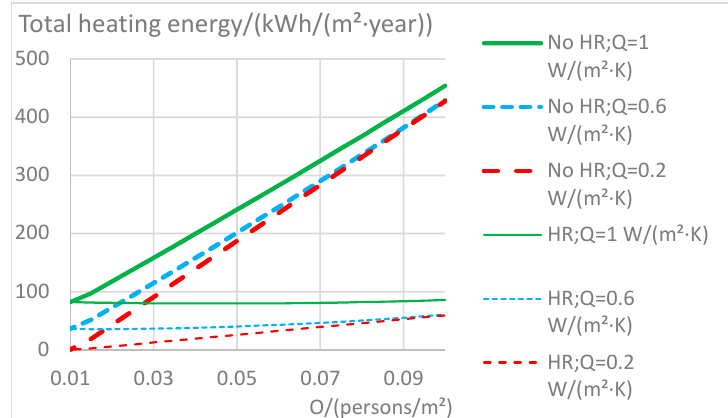
Figure 4. Calculated total heating demand as a function of average occupancy level, O , and heat loss factor, Q , for the building with outdoor climate from Kiruna. ‘HR’ means heat recovery in the ventilation system.